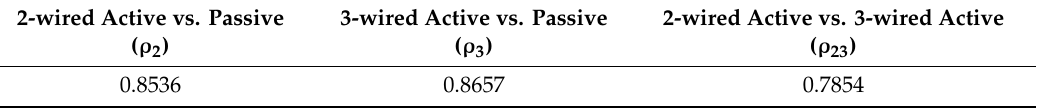
Table 2. Comparison of correlation coe ffi cients for each paired EEG